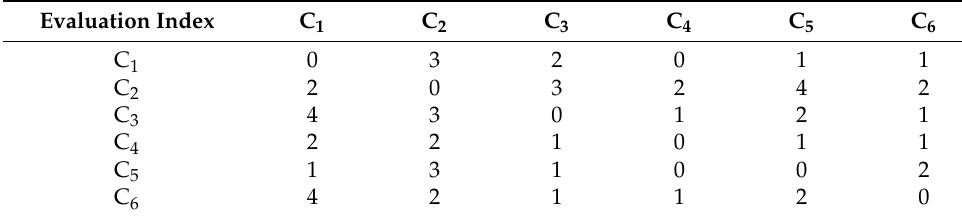
Table 7. Direct correlation matrix Y 2 between indicators of decision maker D 2 .